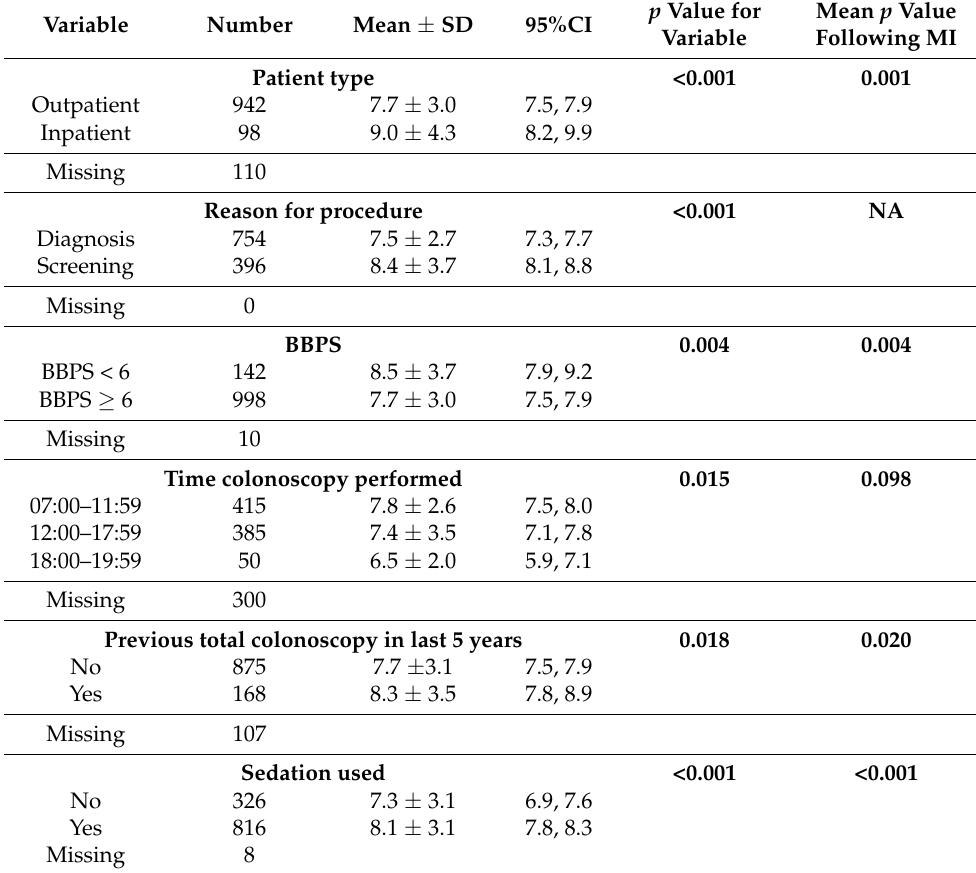
Table 1. Influence of variables on mean withdrawal time